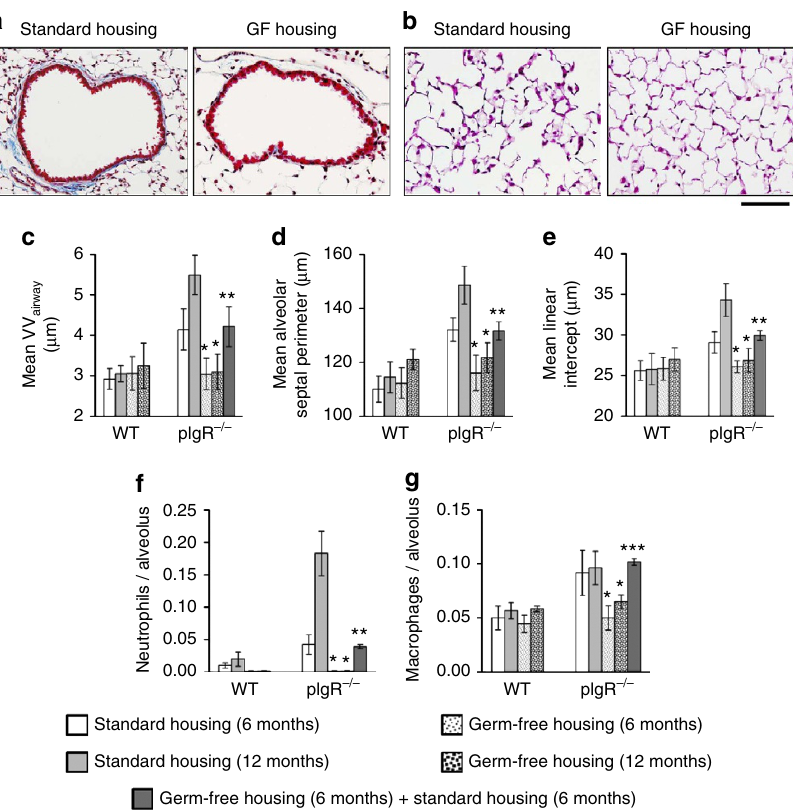
Figure 5 | Germ-free pIgR (cid:2) / (cid:2) mice are protected from COPD-like lung remodelling. ( a ) Representative images of small airway remodelling (Masson’s trichrome, original magnification, (cid:3) 200) and emphysema ( b ) (haematoxylin and eosin (H&E), original magnification, (cid:3) 200) in a 6-month-old pIgR (cid:2) / (cid:2) mouse in standard housing compared with a 6-month-old pIgR (cid:2) / (cid:2) mouse housed in germ-free conditions. Scale bar, 50 m m. ( c – e ) Morphometric analysis of airway wall thickness (VV airway ), alveolar septal perimeter length and mean linear intercept in 6- and 12-month-old WTand pIgR (cid:2) / (cid:2) mice maintained in standard housing, germ-free housing or 6 months of germ-free housing followed by 6 months of standard housing as indicated. ( f , g ) Parenchymal neutrophil (NE þ ) and macrophage (CD68 þ ) counts in lungs of 6- and 12-month-old WTand pIgR (cid:2) / (cid:2) mice maintained in standard housing, germ-free housing or a combination of both as indicated. Six to seven mice per group; * P o 0.001 compared with all other groups, ** P o 0.001 compared with age- matched WT controls housed in standard conditions (two-way analysis of variance